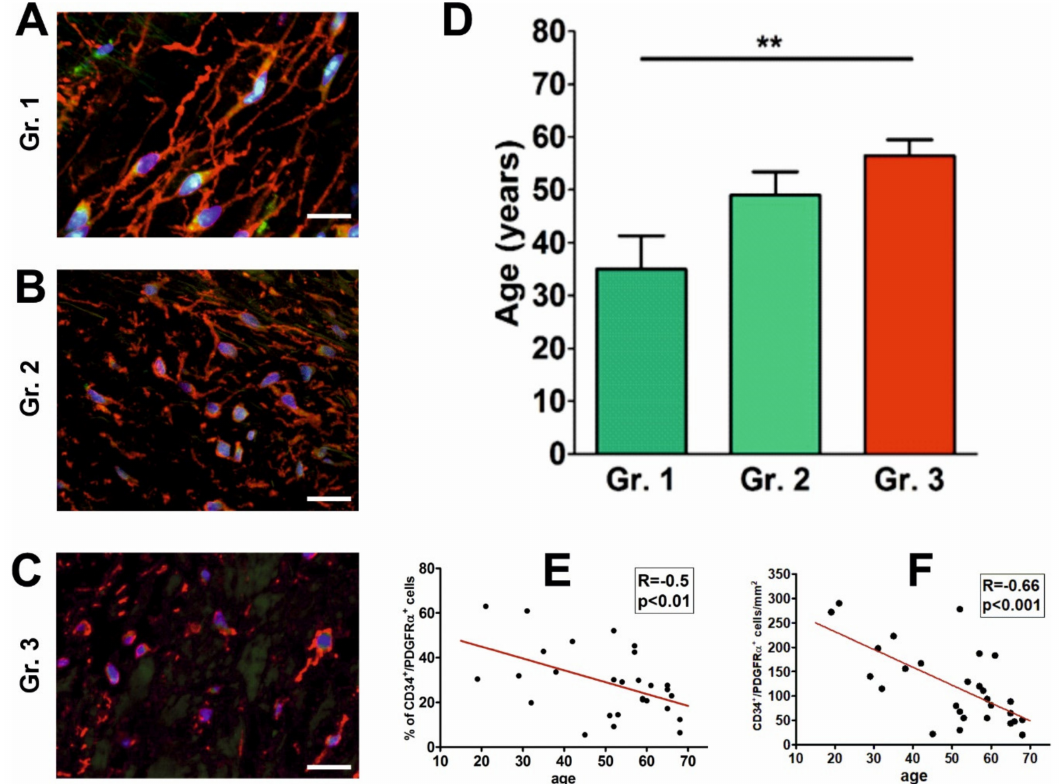
Figure 3. Changes in morphology and abundance of CD34 +/ PDGFR α + cells related to age. ( A – C ) Confocal microscopy images of CD34 +/ PDGFR α + cells representative for the examined valve groups: 1, 2, and 3, respectively. Note, gradual reduction of cell projections comparing Group 1 to Groups 2, and 3. Scale bars = 20 µ m. ( D ) Graph showing the mean age of the valve donors in three groups of aortic valves: Group 1 valves were from significantly younger subjects than Group 3 valves (** p < 0.01; values presented as the means ± SD). Graphs ( E , F ) demonstrate a significant decrease in the CD34 +/ PDGFR α + cell percentage and number, respectively, with